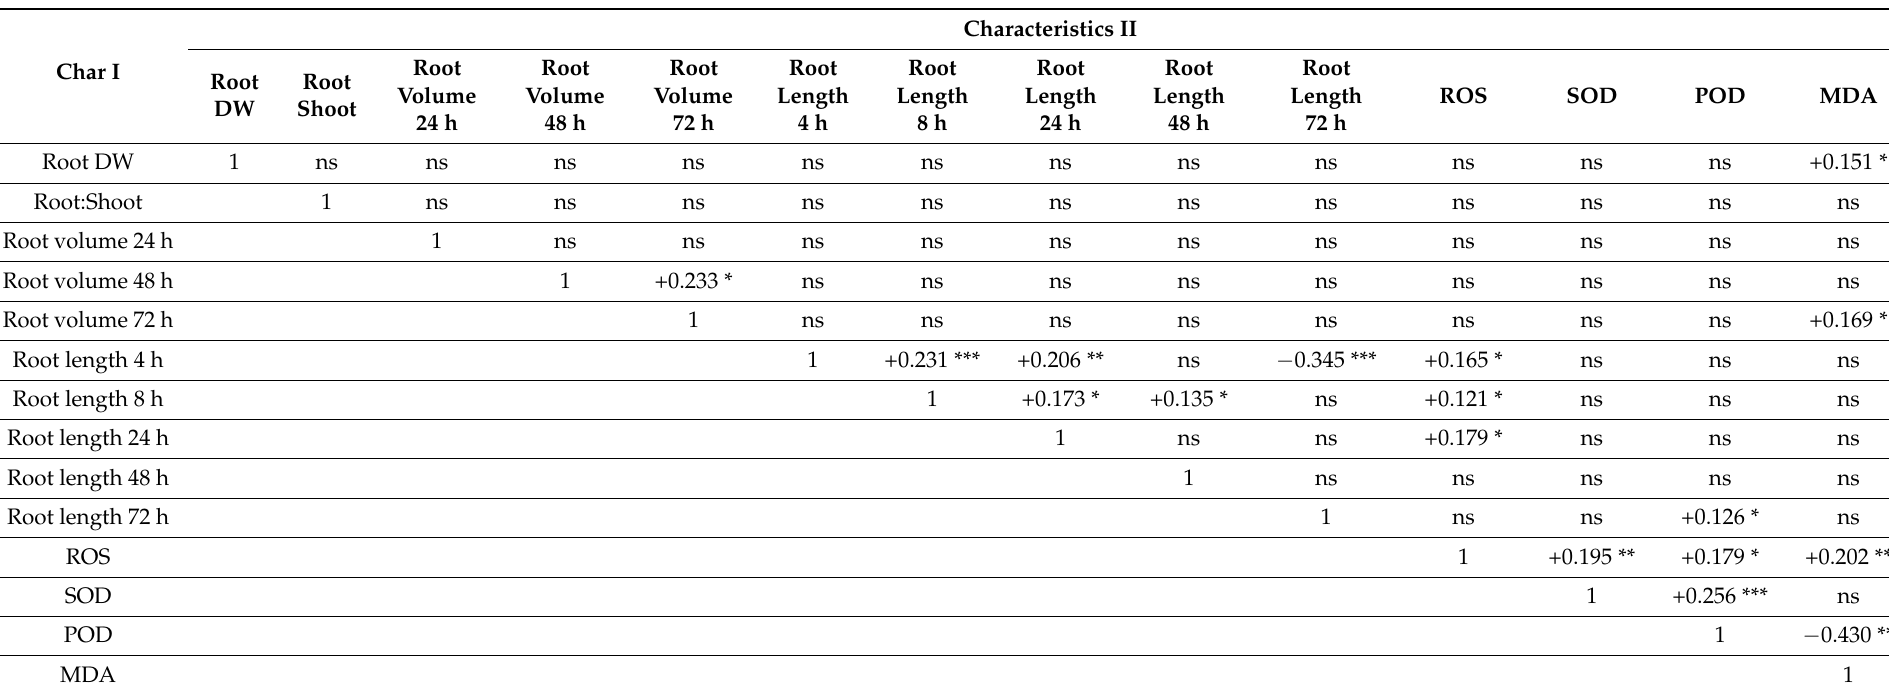
Table 5. Correlations based on the average values for all the cultivars combined under AlCl 3